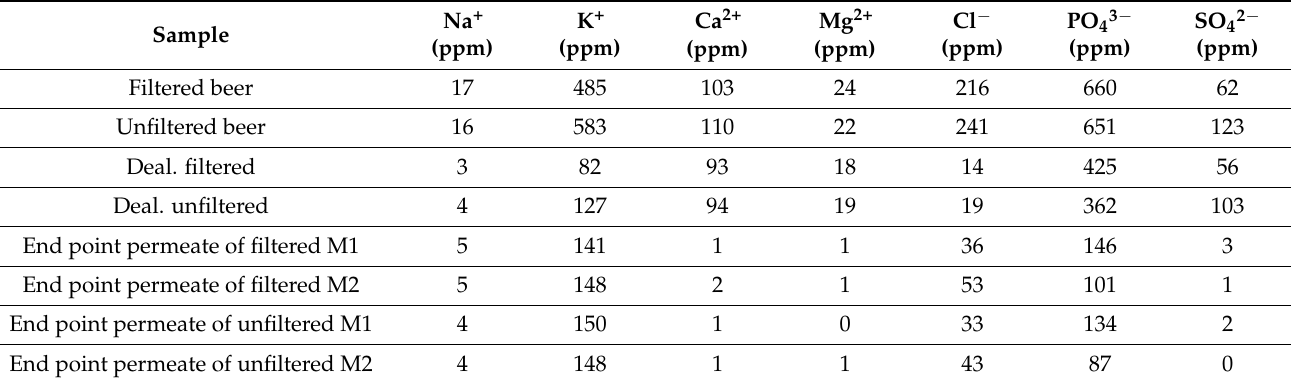
Table 2. Inorganic cation and anion concentrations in original and dealcoholized beer and perme- ate samples.